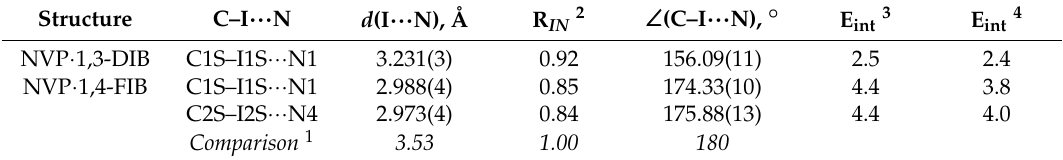
Table 1. Parameters of the C–I ··· N XBs in the co-crystals obtained in this work.